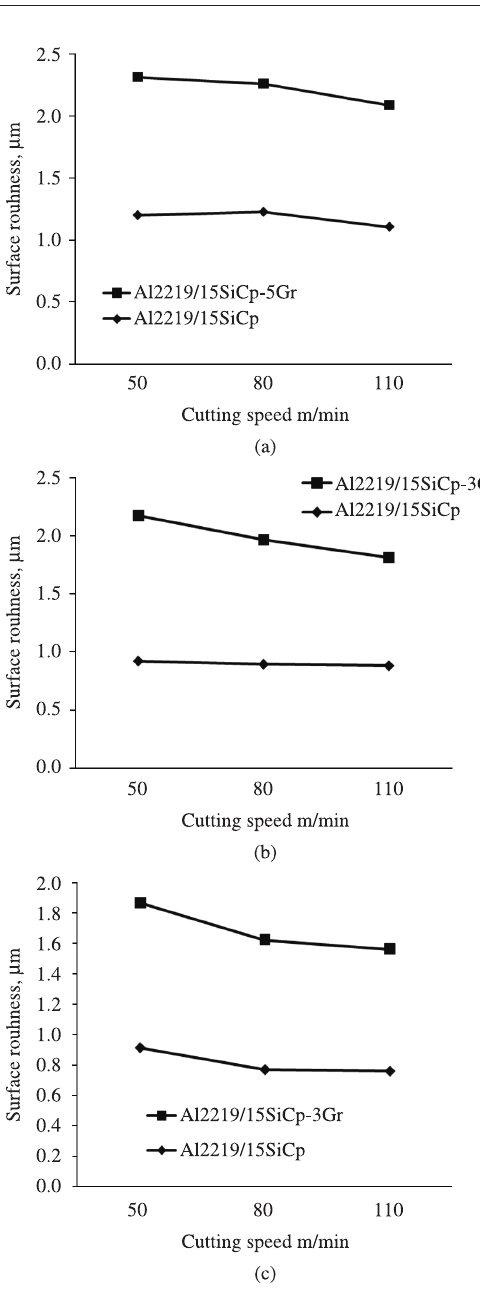
Figure 1. Variation of surface roughness (Ra) with cutting speed for both the composites at a constant length of cutting of 50 mm, feed rate of 0.075 mm/rev and at DOC 0.3 mm for (a) carbide tool (b) Coated Carbide tool and (c) PCD tool.